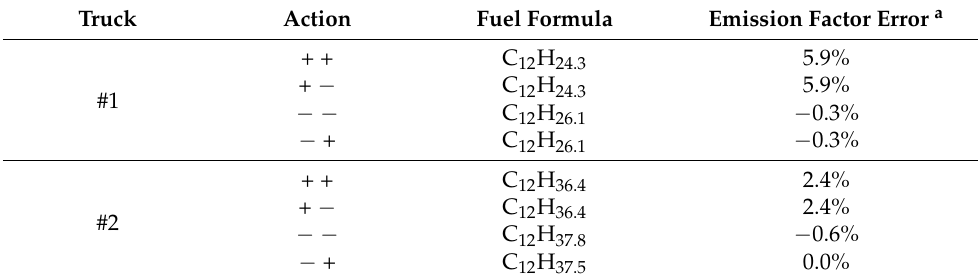
Table 6. The results for the error in relation to the calculated emission